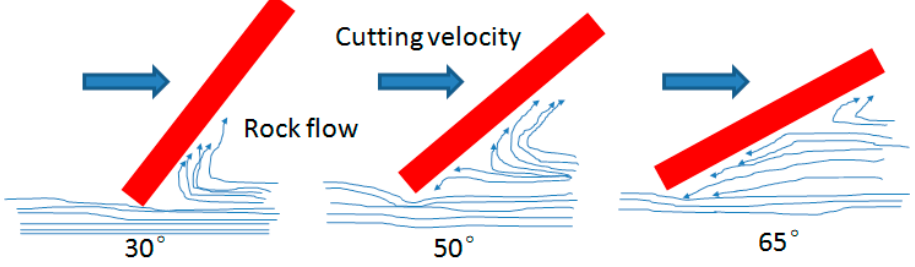
ff erent back rake Figure 6. Rock flow ahead of cutter at different back rake angle. Figure 6. Rock flow ahead of cutter at di Figure 6. Rock flow ahead of cutter at different back rake angle.